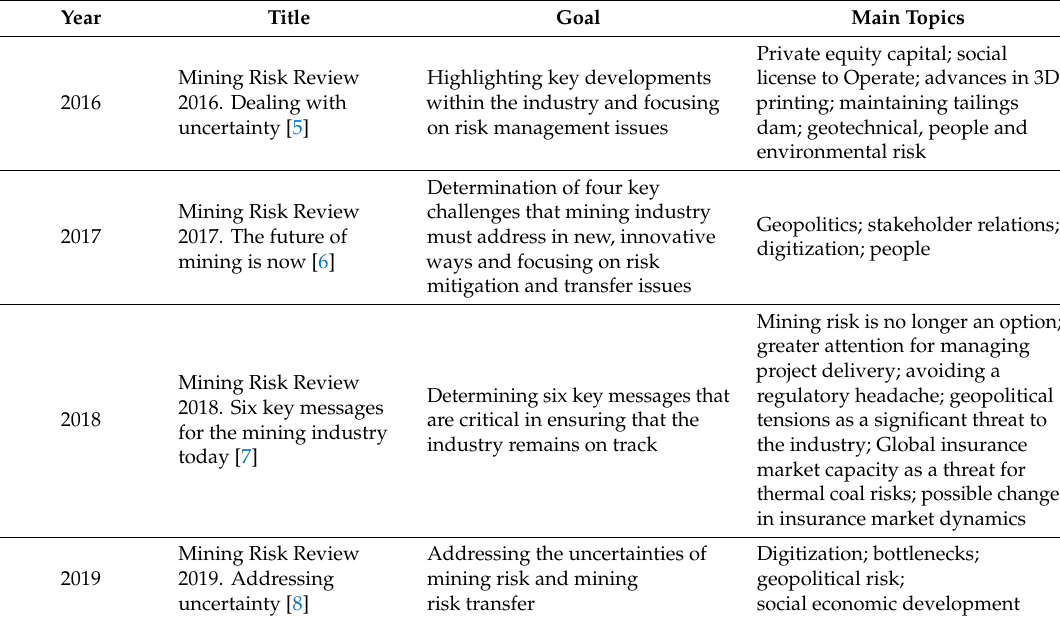
Table 1. The subjects of reports Mining Risk Review